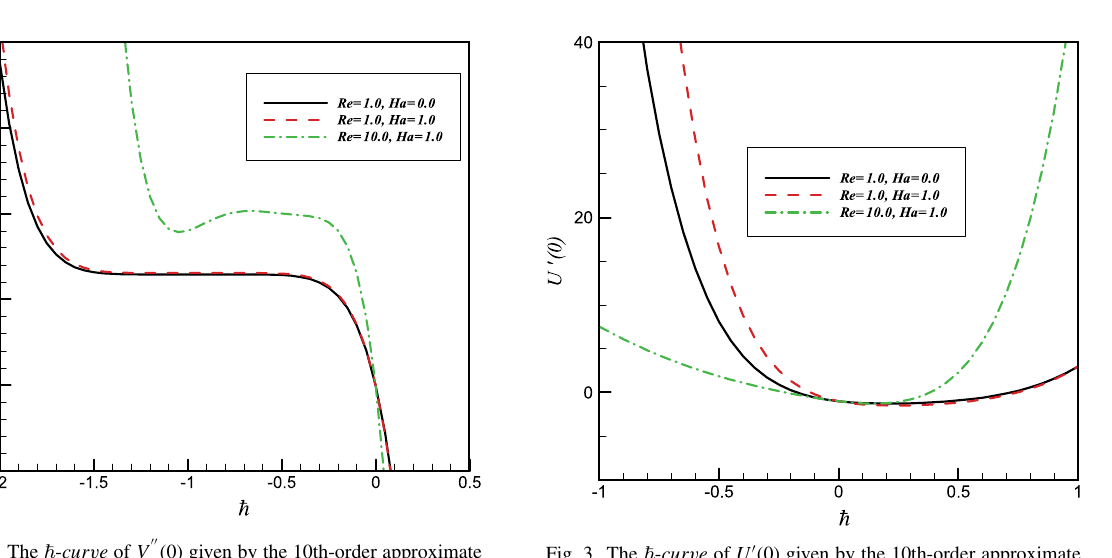
Fig. 3. The (cid:1) - curve of U (cid:2) (0) given by the 10th-order approximate solution, for various values of Re and Ha,